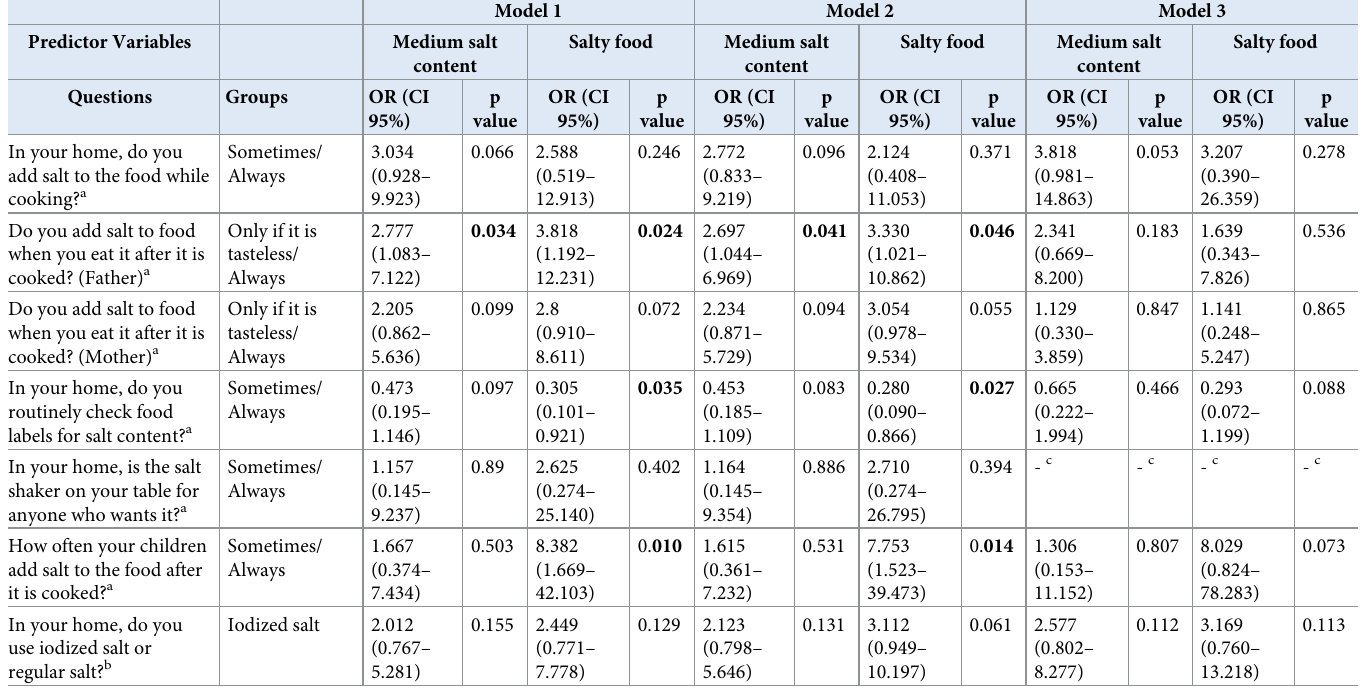
Table 5. Multinomial logistic regression models. Odds ratios and 95% confidence intervals for children’s preference for somewhat salty/very salty